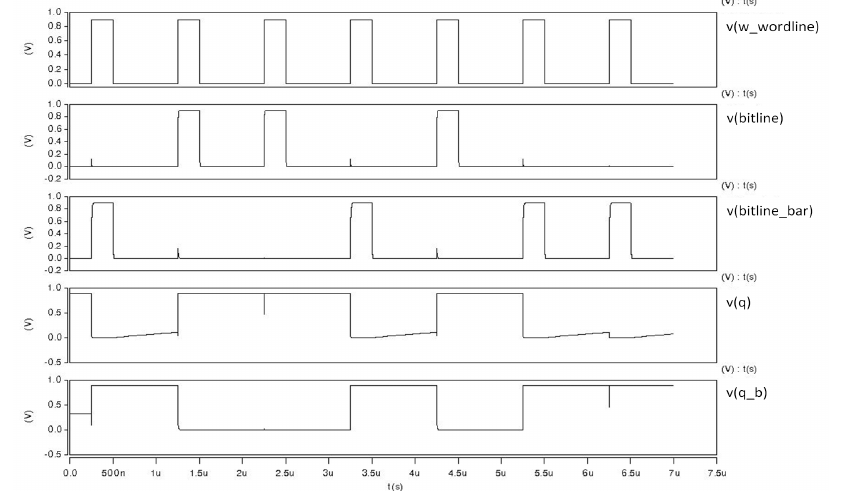
Figure 16. Waveform of write operations in CNFET (sequence of